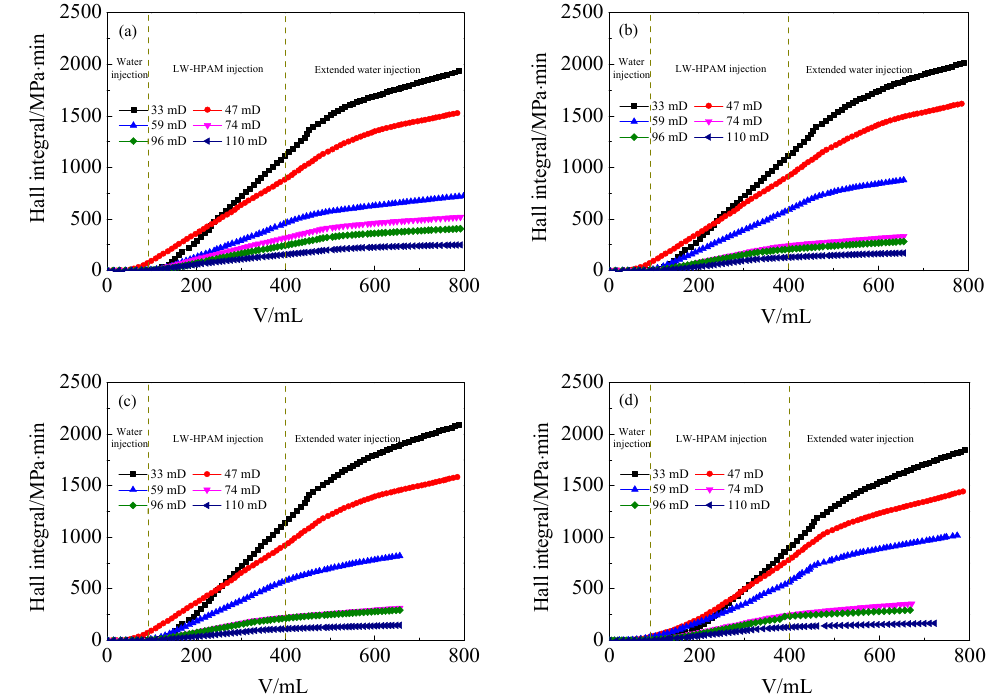
3.3. Injection Performance of HPAM Solutions in Medium and Low Permeability Cores